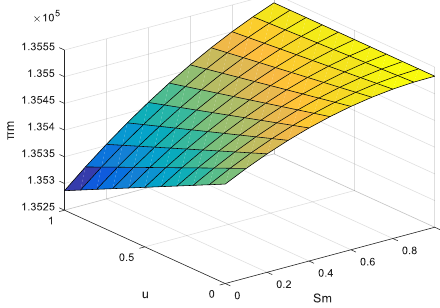
Figure 8. Effect of s m and µ on π m